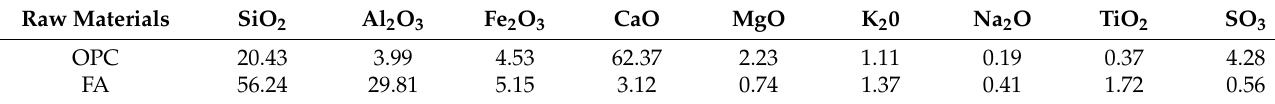
Table 1. Main chemical composition and content of cement and fly ash /%.